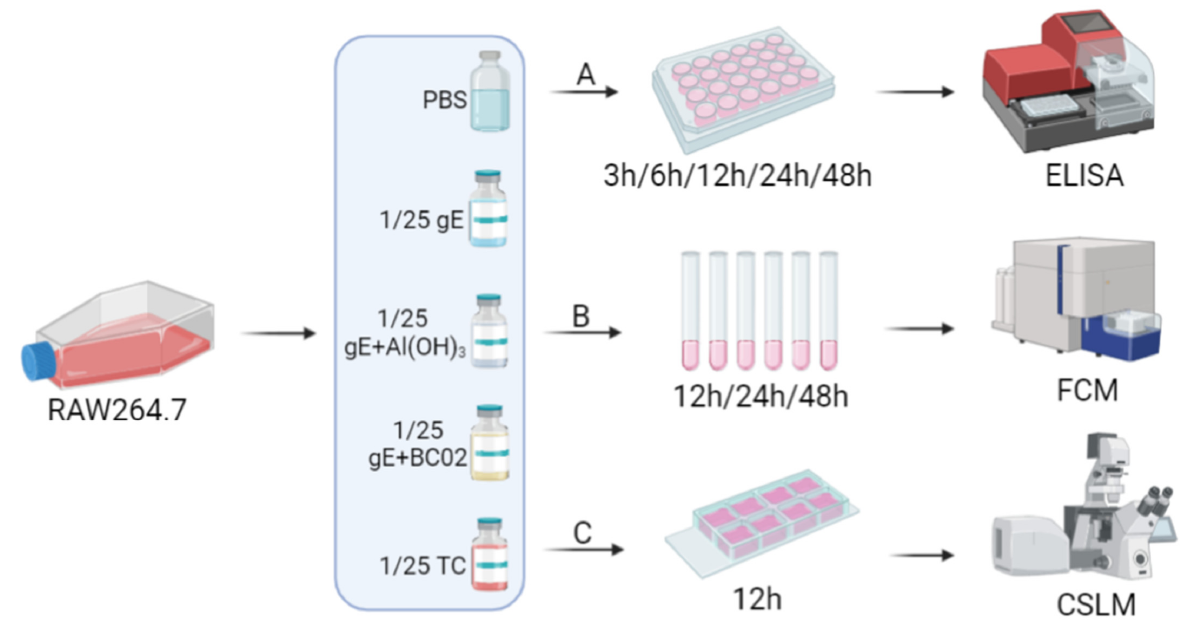
Figure 2. In vitro stimulation analysis of RAW264.7 cells. RAW264.7 cells were stimulated for different times at 37 °C with 1/25 dose of experimental vaccines. ( A ): ELISA was used to detect TNF-a, MCP-1, IL-6 and GM-CSF in cell culture supernatant. ( B ): Flow cytometry was used to detect CD40, CD80, CD206, and I-A/I-E cell surface costimulatory molecules. ( C ): Confocal